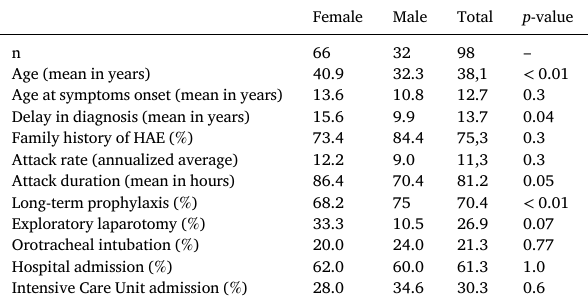
Table 1 Clinical features and treatment of hereditary angioedema according to sex.